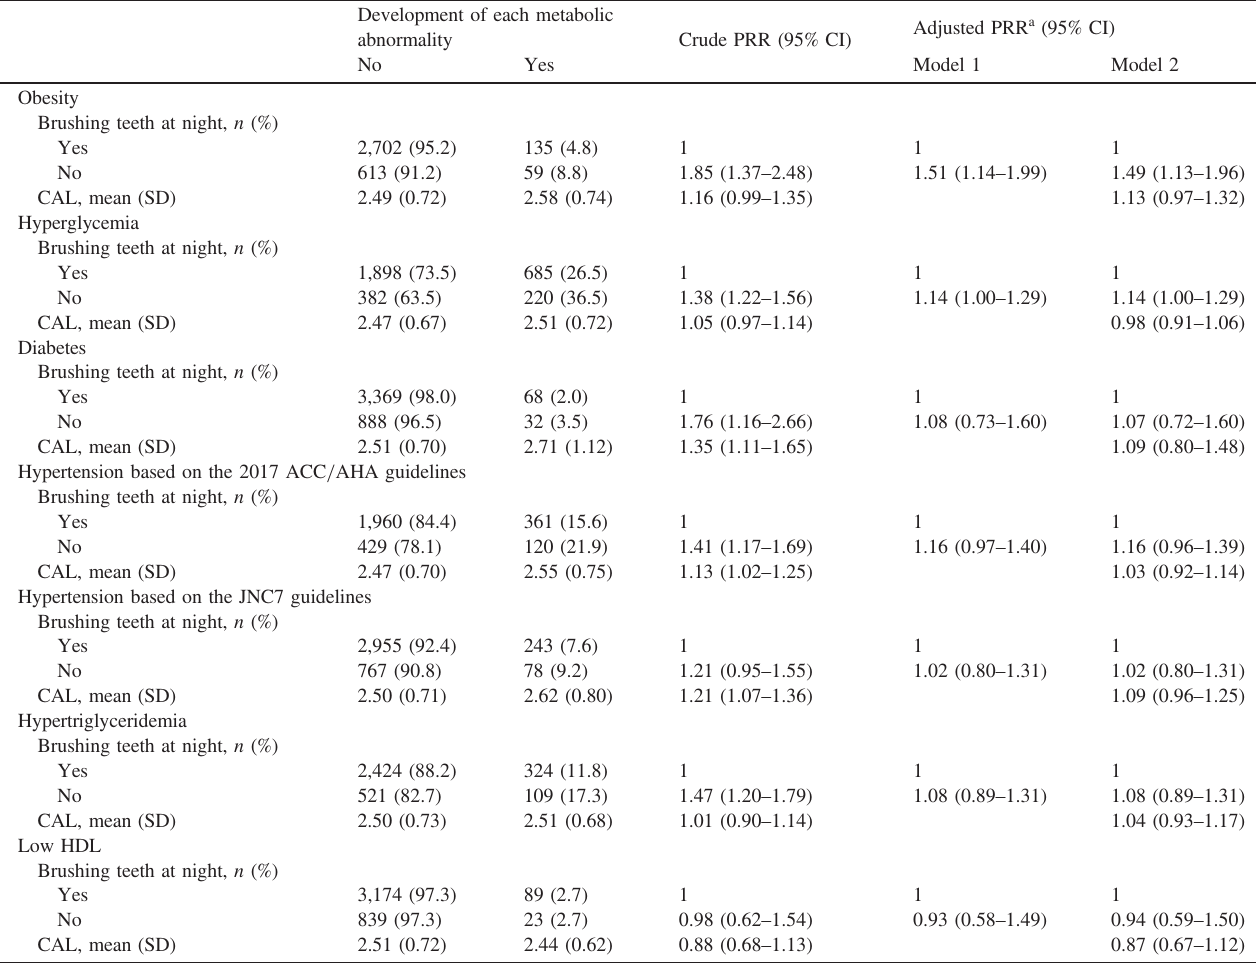
Table 6. Association between brushing teeth at night and the development of each metabolic abnormality Development of each metabolic abnormality